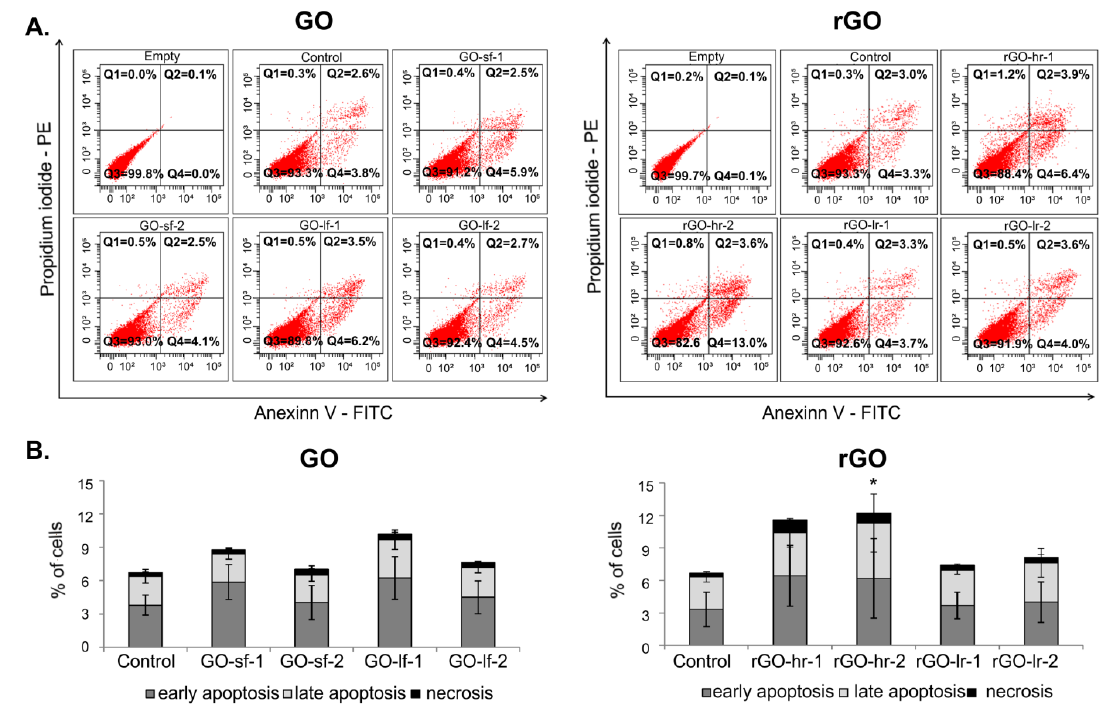
Viability of the hUC-MSCs after 72 h of culture on the GO and rGO substrates. The quantification of cell viability was determined by the flow cytometric analysis of the apoptotic and necrotic cells via the double-staining of hUC-MSCs with Annexin V-FITC and propidium iodide. ( A ) Representative flow cytometric dot-plots are presented to demonstrate the morphology of hUC-MSCs and gating strategy for the determination of the percentages of live (Annexin V-negative and propidium iodide-negative; Q3), early apoptotic (Annexin V-positive and propidium iodide-negative; Q4), late apoptotic (Annexin V-positive and propidium iodide-positive; Q2), and necrotic (Annexin V-negative and propidium iodide-positive; Q1) cells. An unstained probe (empty) constituted the negative control. ( B ) The percentages of early apoptotic, late apoptotic, and necrotic cells were determined using the FACS Diva software. p Value less than 0.05 ( p < 0.05) was considered statistically significant and labeled by an asterisk (*). Legend: GO-sf-1: small flakes / thick layer; GO-sf-2: small flakes / thin layer; GO-lf-1: large flakes / thick layer; GO-lf-2: large flakes / thin layer; rGO-hr-1: high reduction level / thin layer; rGO-hr-2: high reduction level / thick layer; rGO-lr-1: low reduction level / thin layer; rGO-lr-2: low reduction level / thick layer; Control: tissue culture plastic surface (TCPS).